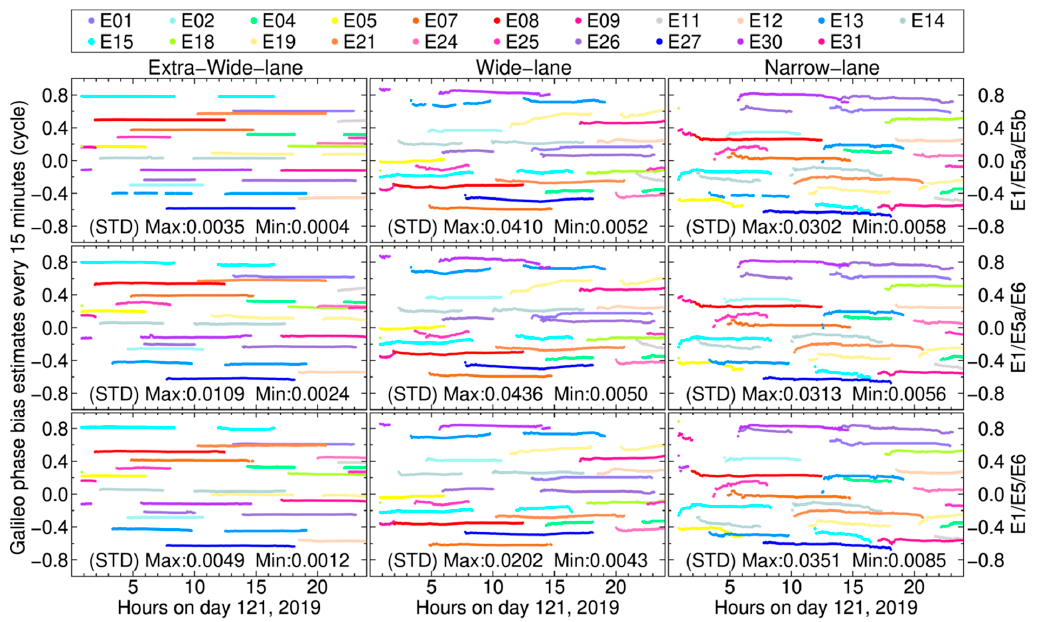
Figure 4. ( left ) Extra-wide-lane, ( middle ) wide-lane, and ( right ) narrow-lane phase biases for all Galileo satellites involved every 15 min on day 121, 2019. The phase biases are estimated based on ( top ) E1 / E5a / E5b, ( middle ) E1 / E5a / E6, and ( bottom ) E1 / E5 / E6 signals, respectively. Di ff erent colors denote di ff erent Galileo satellites. Maximum and minimum of standard deviations (STDs) ( cycle ) of the phase biases of all satellites are shown in each subfigure. Note that the phase biases have been o ff set vertically to avoid the overlaps. The interrupts in some results are caused by the raw GNSS data.